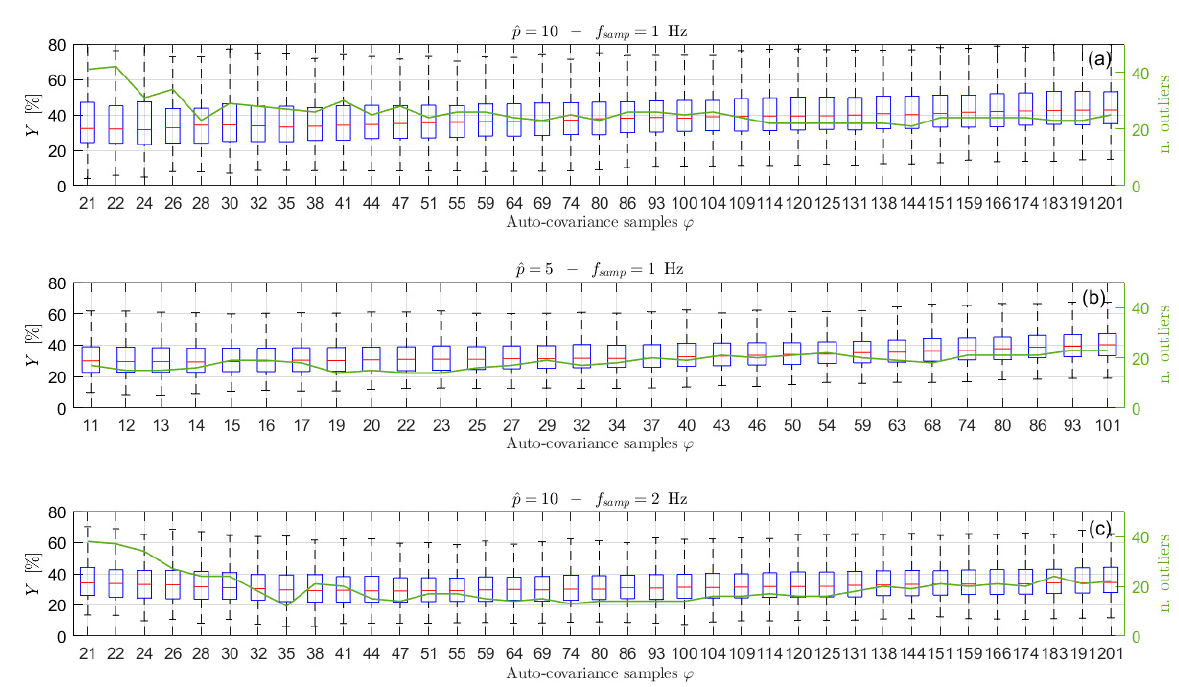
Figure 10. Box plot (left vertical axis) and number of outliers (solid line and right vertical axis) as functions of the number ϕ of auto − covariance samples used to write Equation (14) for x 600 s long with ˆ p = 10 and f samp = 1 Hz ( a ) ˆ p = 5 and f samp = 1 Hz ( b ) and = 10 and f samp = 2 Hz ( c